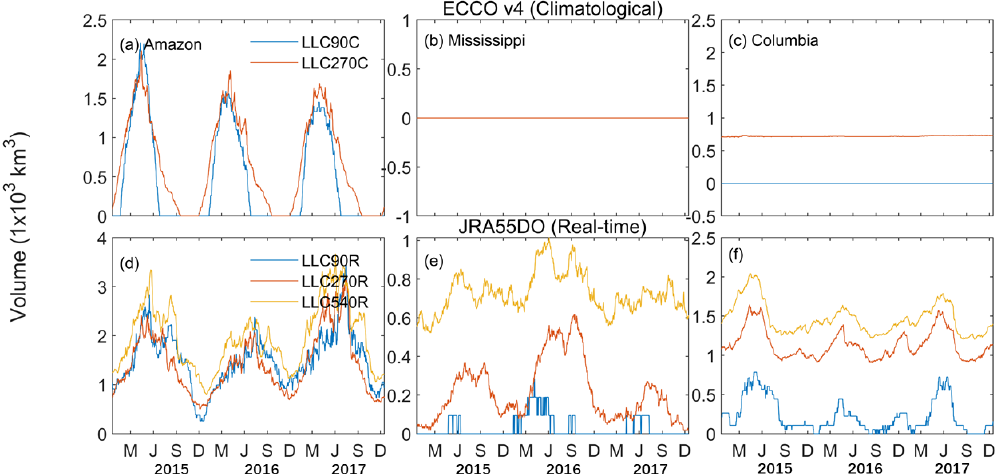
Figure 9. Freshwater volume within 30PSU for the Amazon, Mississippi, and Columbia river regions for various experiments; reference salinity is